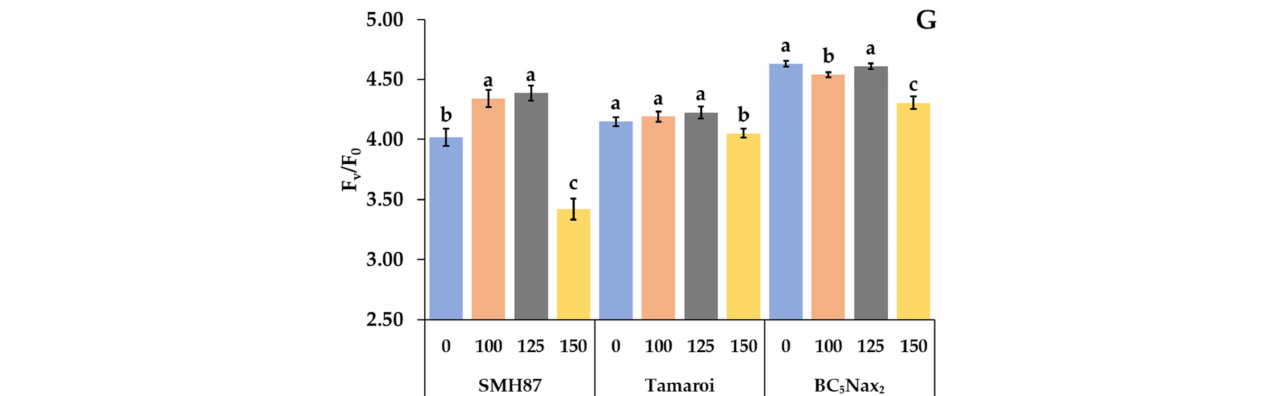
Figure 3. Effects of NaCl treatments (0, 100, 125, 150 mM) on chlorophyll a parameters: ABS/CS m — energy absorption by antennas ( A ); TR o /CS m —excitation energy trapped in PSII ( B ); ET o /CS m — energy used for electron transport ( C ); DI o /CS m —energy dissipation from PSII ( D ); RC/CS m — number of active reaction center ( E ); PI—performance index ( F ); F v /F 0 —maximum efficiency of water-splitting reaction of the donor side of PSII ( G ). The values represent means (n = 10) ± SE within each accession, and those marked with the same letters do not differ statistically according to multiple range Duncan’s test ( p < 0.05).